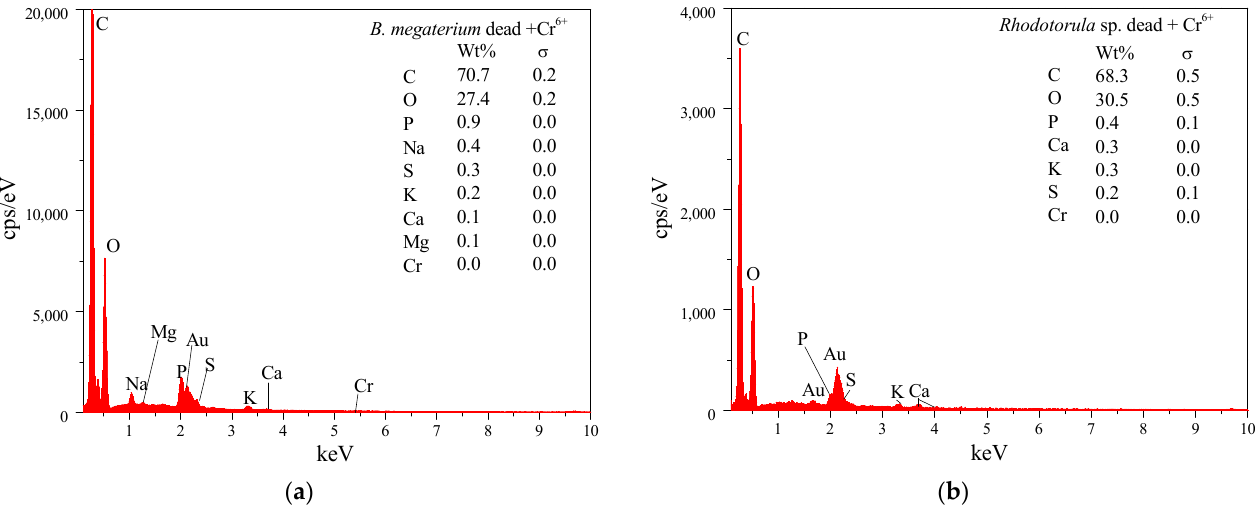
Figure 12. SEM analysis of Rhodotorula sp. surface ( a ) before and ( b ) after Cr 6+ biosorption.